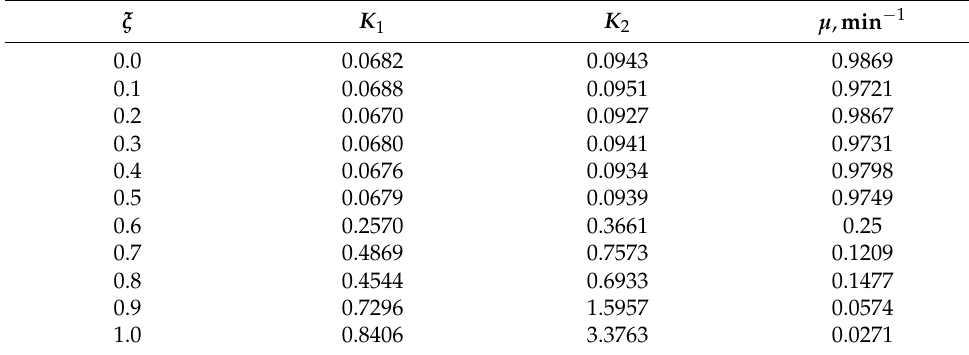
Table 1. Optimization results by the method using the genetic